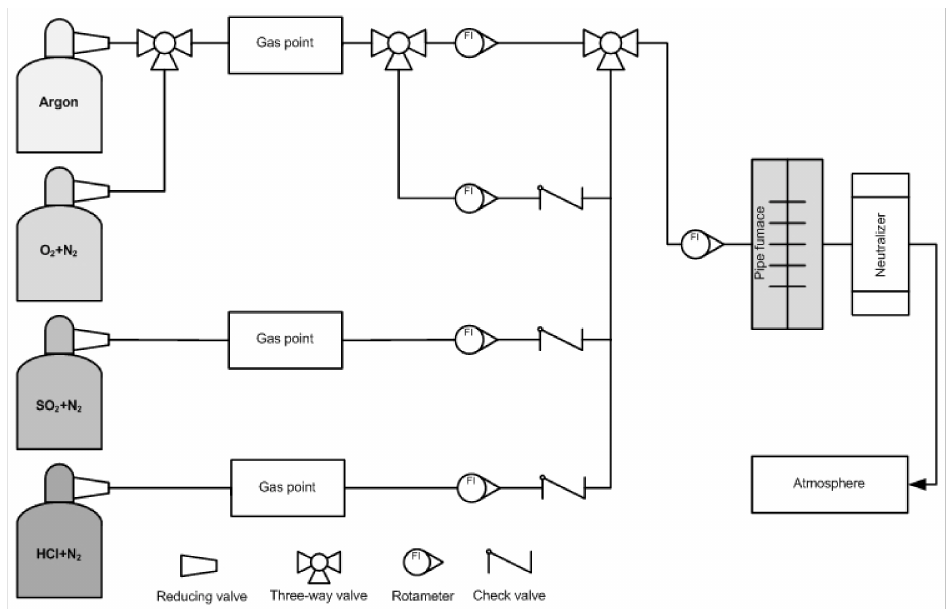
Figure 4. Scheme of equipment for corrosion